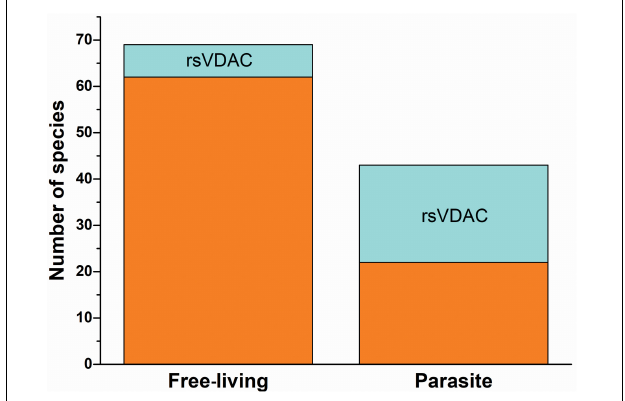
FIGURE 4 | The occurrence of redox-sensitive VDAC in free-living organisms and